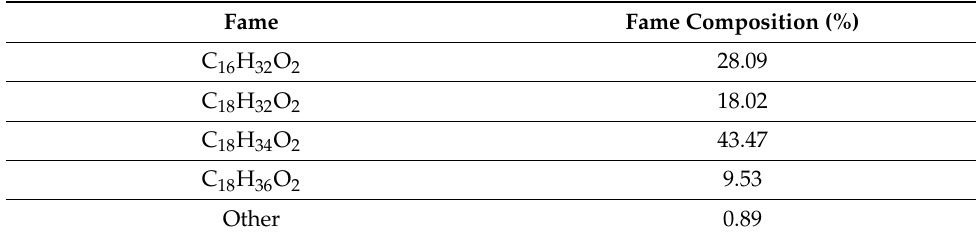
Table 2. Fatty acid profile of biodiesel used in this research.